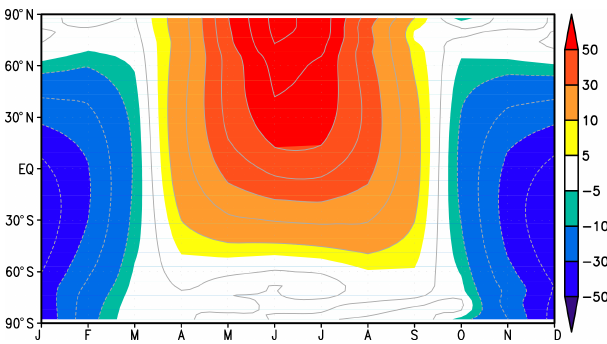
Figure 1. Latitude–month insolation anomaly between 127k and PI (Wm − 2 ). The calendar for 127k is adjusted using a method based on Bartlein and Shafer